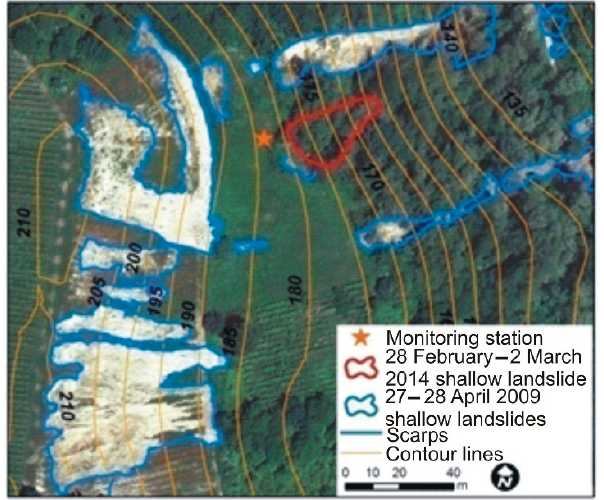
Figure 2. Detailed view of the testsite slope where the monitoring station was installed, showing evidence of the shallow landslides triggered during the 27–28 April 2009 event. The aerial photograph of the area was captured by Ditta Rossi s.r.l. (Brescia, Italy) on 18 May 2009.